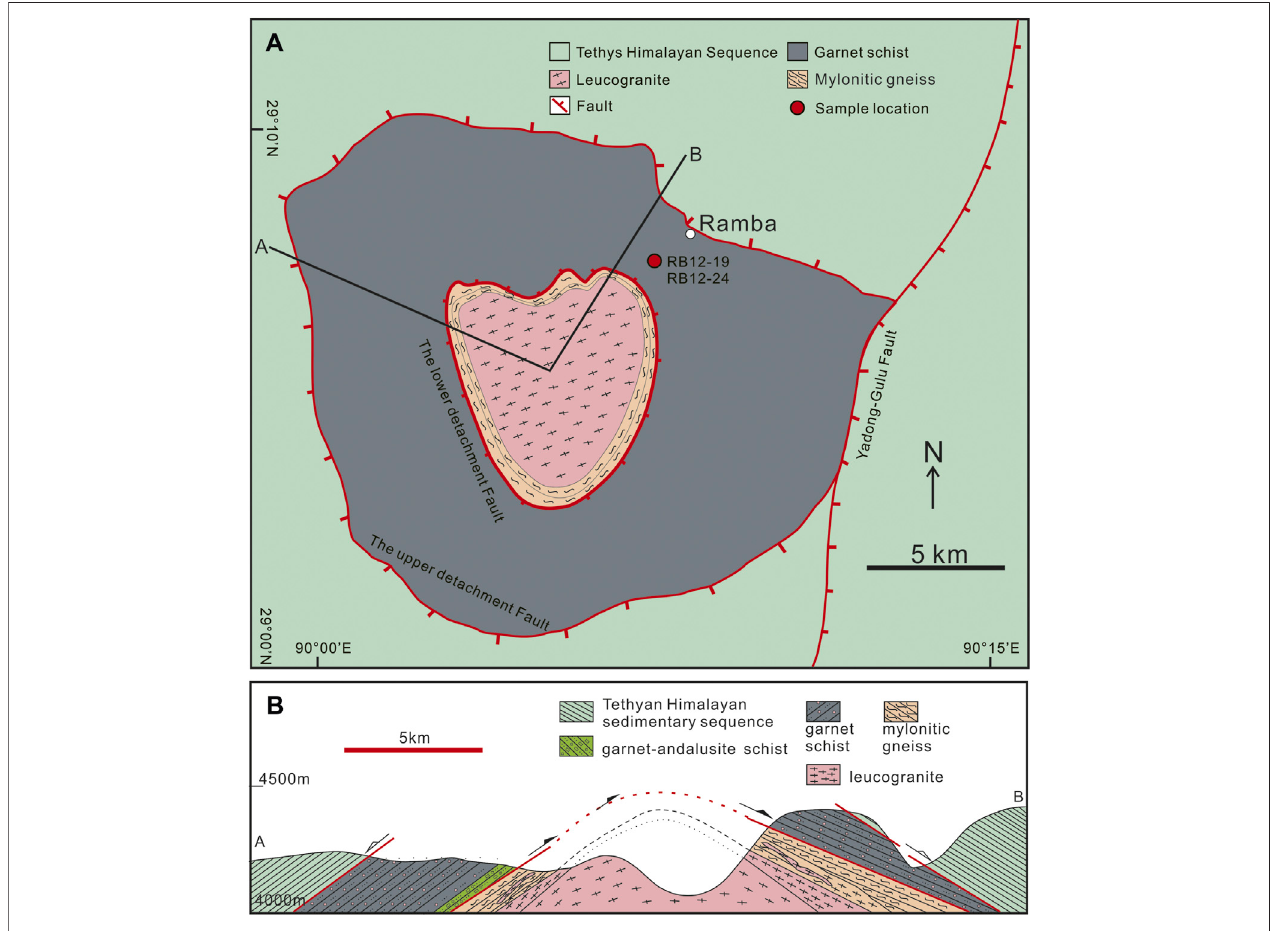
FIGURE 2 | (A) Schematic geological map showing the Ramba gneiss dome and (B) cross-section (modi fi ed from Zhang et al., 2012).